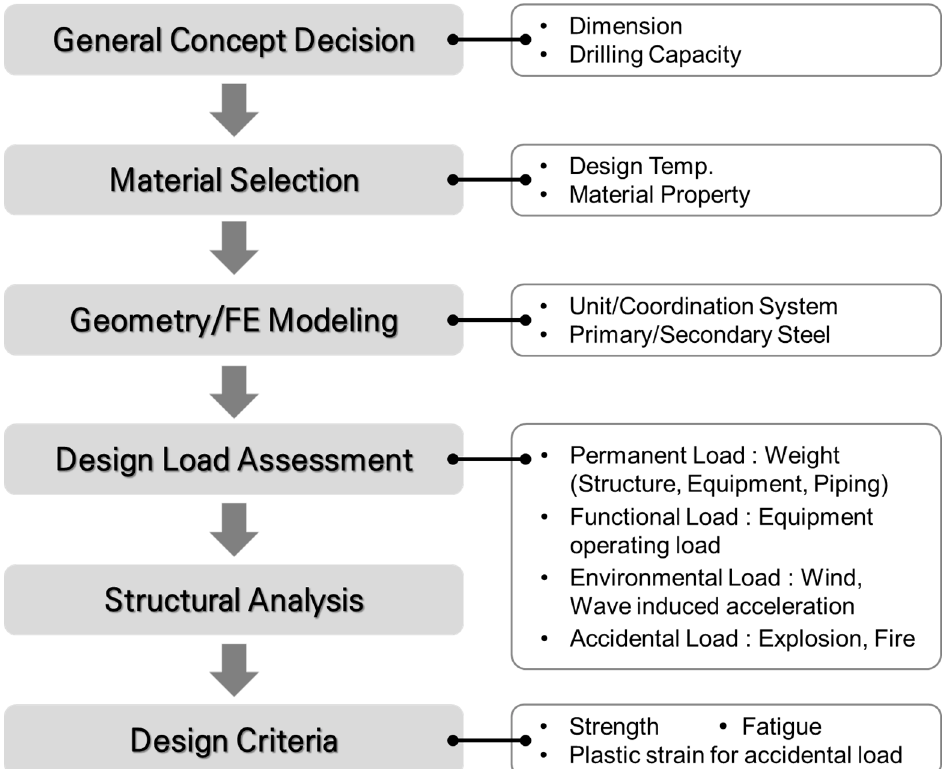
Figure 2. Procedure of drill floor design.